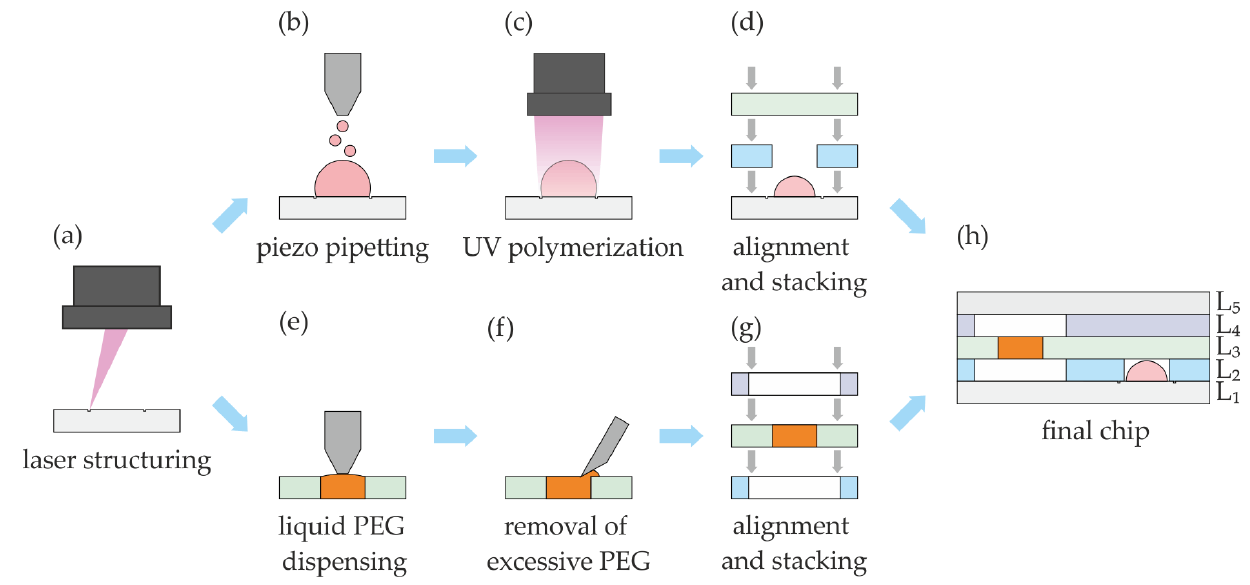
Figure 2. General process flow of fabrication of multilayer chemofluidic ICs with multi-material printing. The different valve types are manufactured in separate layers (upper process flow ( b – d ) for hydrogel-based closing valves; lower process flow ( e – g ) for soluble PEG opening valves; ( a ) laser structuring of the polymer layers, including engraving; ( b ) ink-jet printing of prepolymer solution; ( c ) UV exposure of prepolymer solution; ( d ) alignment, stacking and bonding of the closing valve sub-stack; ( e ) dispensing of molten PEG; ( f ) removal of excessive PEG; ( g ) alignment, stacking and bonding of the opening valve sub-stack; and ( h ) combination of the sub-stacks to the complete chip with L 1 + L 3 PMMA foil, L 2 + L 4 PE foil with adhesive 9960 on both sides, L 5 PMMA foil with 9795R on top side.